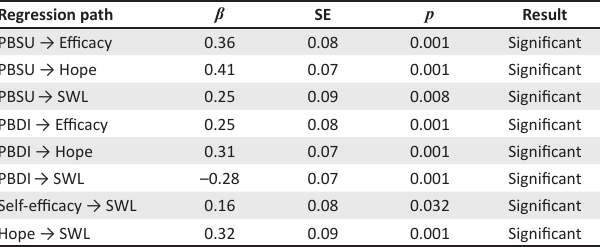
TABLE 2: Standardised estimates for the structural